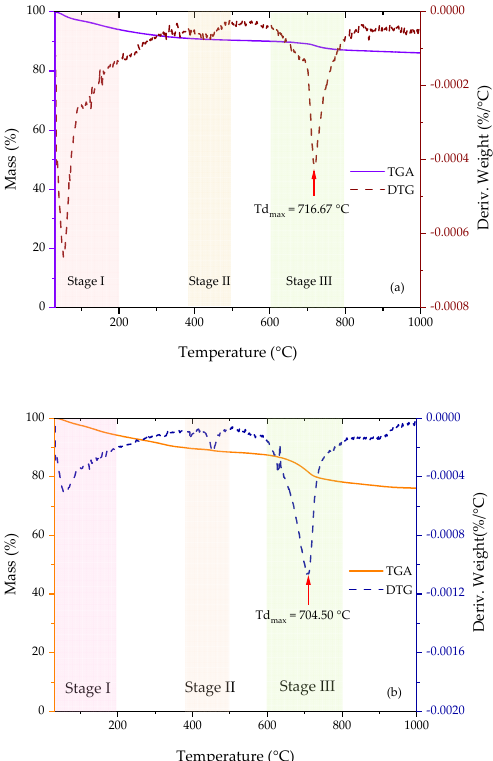
Figure 9. TGA and DTG curves of thermal decomposition of ( a ) 1DP − nHAp and ( b ) 2DP − nHAp.